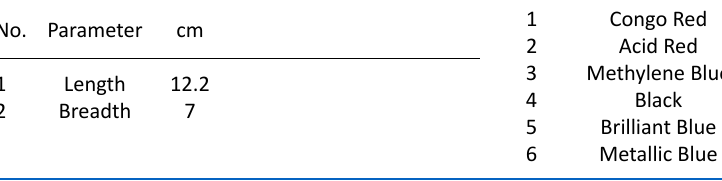
Table 3. Measurements for polyethylene